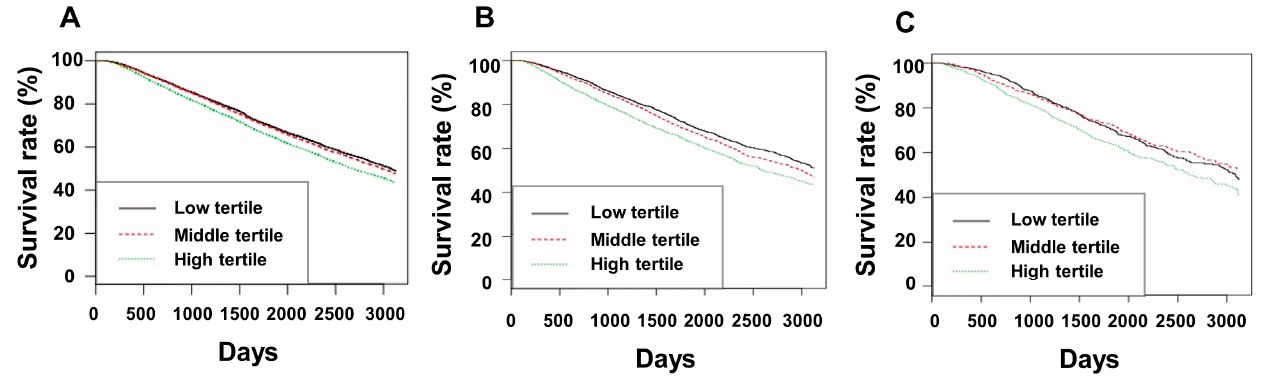
Figure 3. Kaplan–Meier curves of patient survival according to tertile of ESA doses in EP ( A ), DP ( B ), and MR ( C ) groups. For EP group, p -values were 0.045 for low vs. middle tertile, <0.001 for low vs. high tertile, and <0.001 for middle vs. high tertile. For DP group, p -values were 0.003 for low vs. middle tertile, <0.001 for low vs. high tertile, and <0.001 for middle vs. high tertile. For MR group, p -values were 0.474 for low vs. middle tertile, 0.006 for low vs. high tertile, and 0.002 for middle vs. high tertile. Abbreviations: EP, group treated with short-acting erythropoiesis-stimulating agents; DP, group treated with intermediate-acting erythropoiesis-stimulating agents; MR, group treated with long-acting erythropoiesis-stimulating agents.